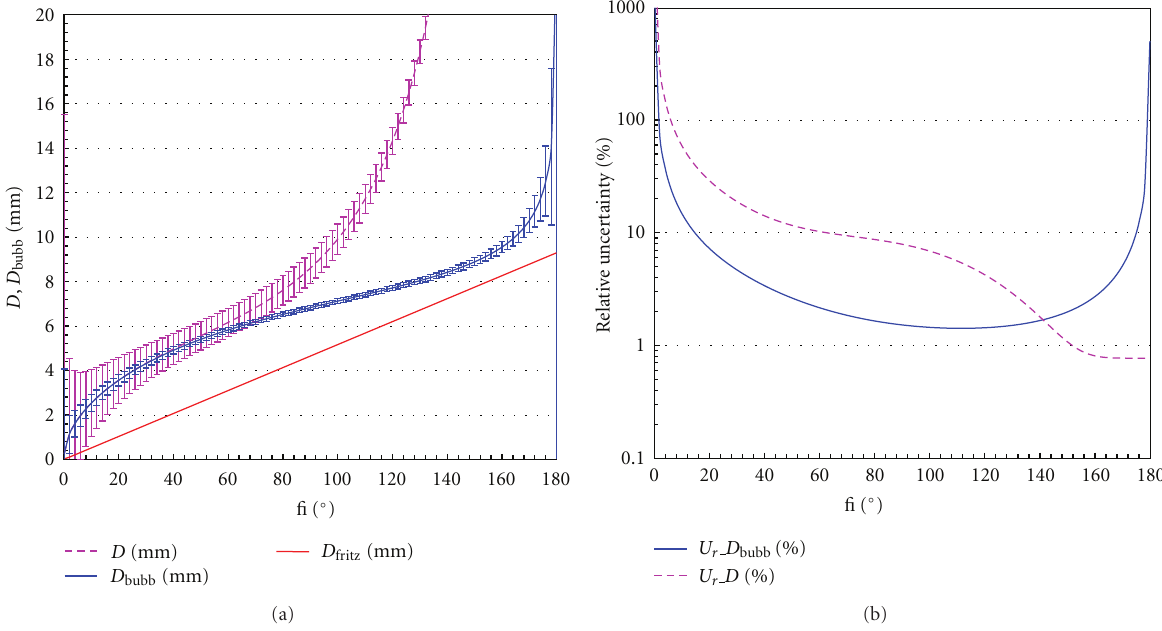
Figure 4: Calculated diameters with error bars for growing bubble (virtual sphere) and departing bubble with diameter calculated from Fritz correlation (a). Relative uncertainty of the calculated bubble departure diameter and virtual sphere diameter